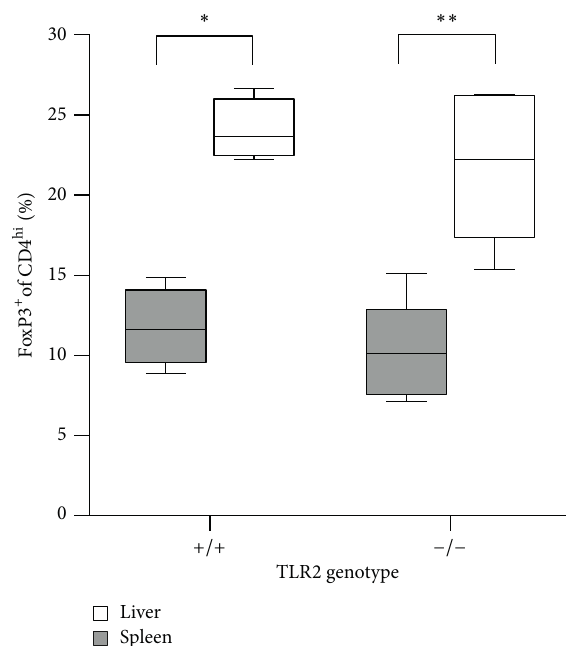
Figure6:TheincreasedfrequencyofFoxP3 + CD4 + cellsinpostnatal liver is independent of TLR2. Liver and spleen FoxP3 + CD4 + cell frequency data are shown for 8- to 9-day-old littermate C57Bl/6- background Tlr2 +/+ mice and Tlr2 −/− mice. 𝑁 = 4 to 5 mice per genotype. Statistical analyses used the nonparametric Mann- Whitney